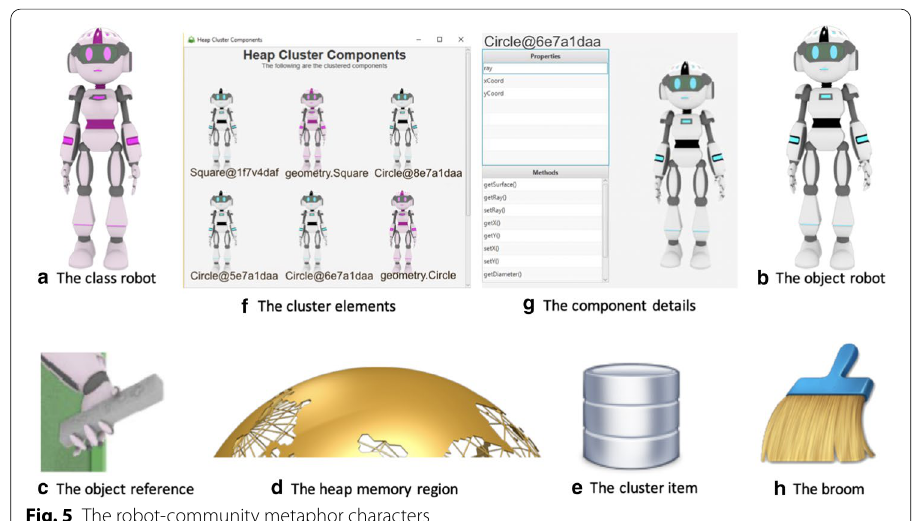
Fig. 5 The robot-community metaphor